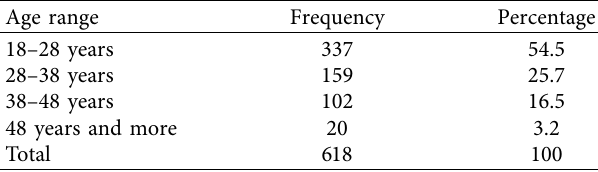
Table 1: Frequency distribution by age category.